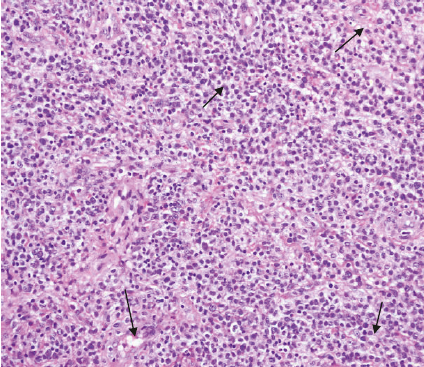
Figure 3: Anal tissue: H&E stain low power showing the tumor consisting of blasts with scant cytoplasm and round-oval nuclei with fi ne dispersed chromatin and distinct nucleoli. Mitotic fi gures are